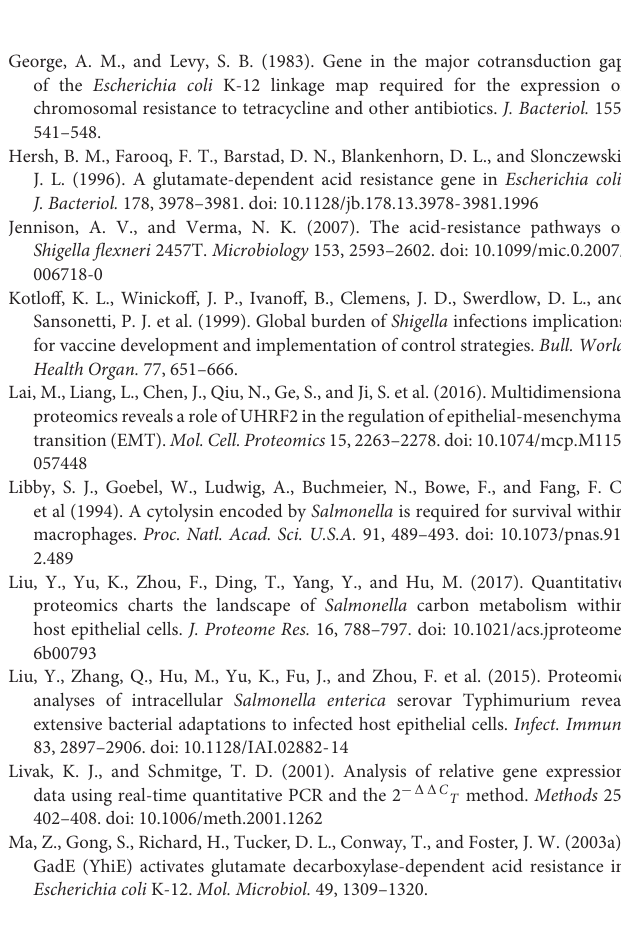
TABLE S1 | All strains and primers used in this study. TABLE S2 | All identified bacterial proteins. TABLE S3 | Virulence proteins identified in the proteomic